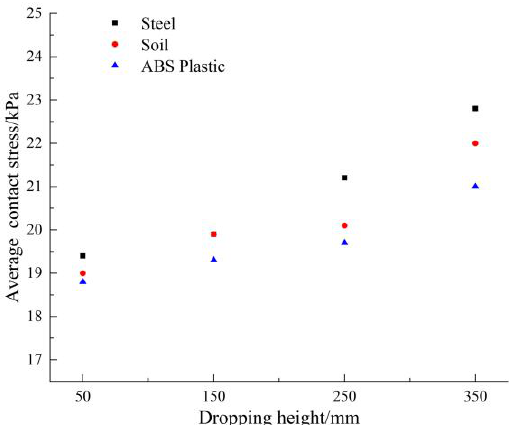
Figure 11. The relationship between average contact stress and drop height of different contact materials.